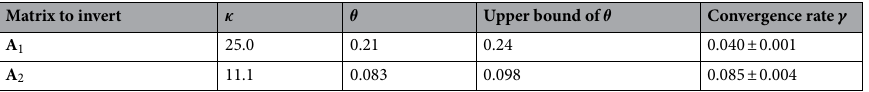
Table 1. Normalized errors and the convergence rate of the 8-bit Richardson iterations used to obtain the inverse of A 1 and A 2 . A 95% confidence bound is used in exponential fitting.